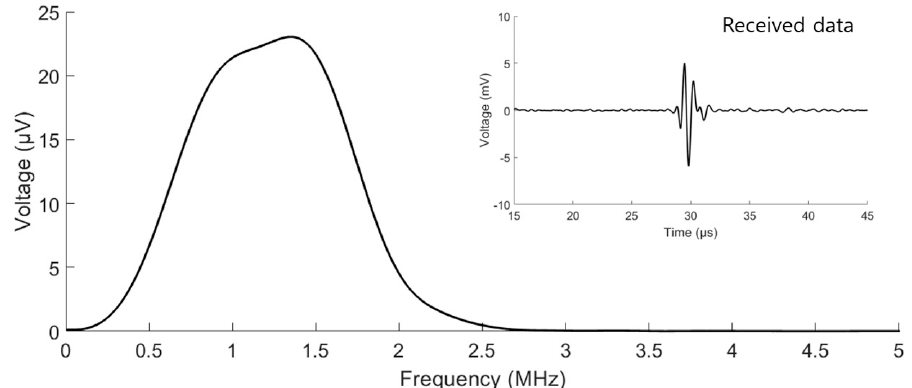
Figure 5. Fast-Fourier-transformed and received data generated by the strain sensor.